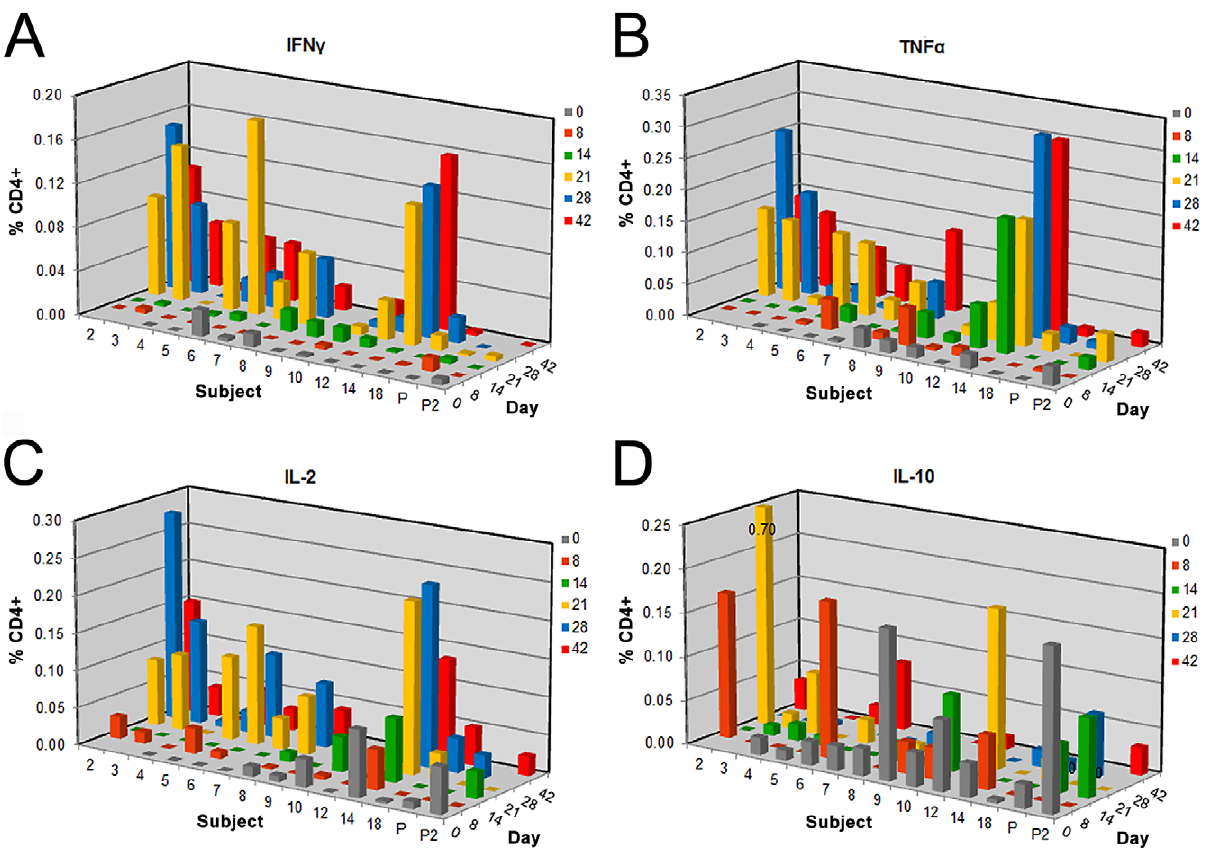
Figure 1. Proinflammatory cytokines are produced at specific times post-vaccination with live DENV-1. Cytokine profiles for 12 subjects vaccinated with 10 PFU of live monovalent DENV-1 and 2 placebo recipients. CD4 + -dependent production of 4 cytokines are shown for pre- vaccination (day 0) and 5 post-vaccination time-points following ex vivo stimulation with homologous, wild type DENV-1 antigen: A. IFN c , B. TNF a , C. IL-2 and D. IL-10. Responses shown are the percentage of cytokine positive T cells from DENV-1-stimulated PBMCs with the background percentage of cytokine-positive T cells in the negative control (Vero) subtracted. Clinical information for each subject is shown in Table 1 . Significantly higher levels of IFN c and TNF a were observed on days 21, 28 and 42 ( p , 0.05 for IFN c and p , 0.01 for TNF a ), and on days 21 and 28 for IL-2 ( p , 0.01). For A– C , p , 0.0001 for group by day differences demonstrating increased cytokines with time compared to day 0.